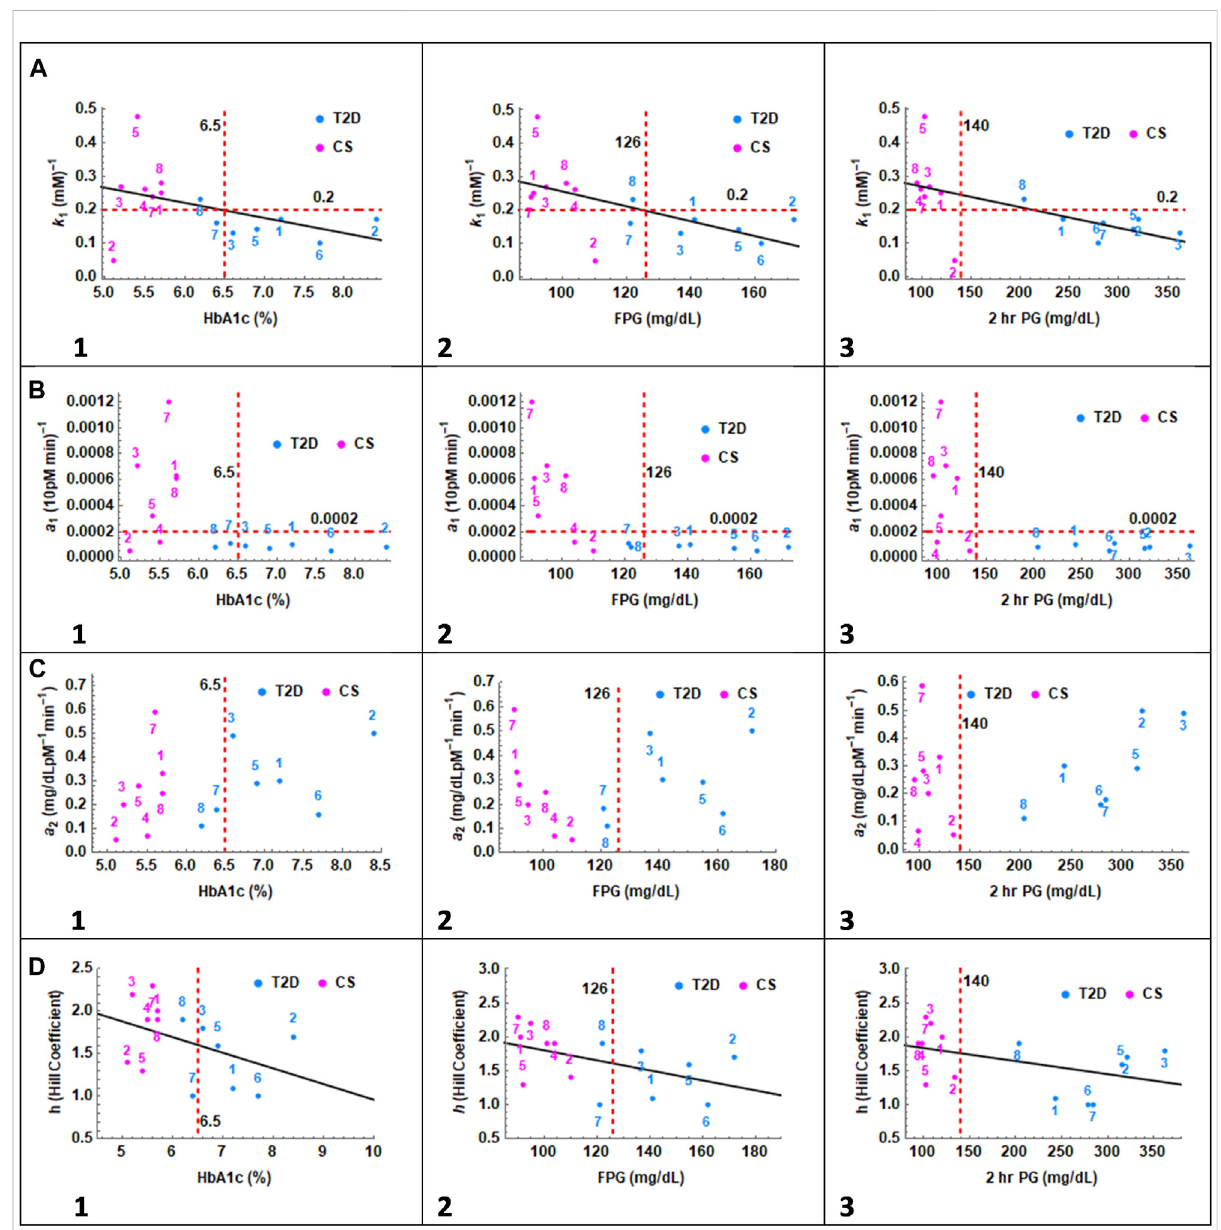
FIGURE 5 Intheseriesofpanels (A) through (G) ,theparametersrelatedtoglucagon suppressionk 1 ,insulinactiona 1 ,glucagon actiona 2 ,Hillcoef fi cienth, infused glucose, insulin secretion γ 1 and glucagon secretion γ 2 are plotted as a function of HbA1c, FPG and 2 h PG values. In panel (A) 1, 2, and 3, CS and T2D subjects partition into distinct quadrants except for one CS subject. A linear relationship is observed between glucagon suppression and HbA1c, FPG, and 2 h PG. The cutoff value separating patients with T2D, and CS subjects is set at 0.2. In Panel (B) , the correlation with insulin sensitivity parameter a 1 is presented. CS subjects and patients with T2D again partition into two distinct quadrants except for CS 2 and 4. The cutoff valueseparatingpatientswithT2D,andCSsubjectsis0.0002.Inpanel (C) nocleardistinctionbetweenpatientswithT2DandCSsubjectsisobserved withrespecttoglucagon actionparameter a 2 . InPanel (D) ,theHillcoef fi cient,h,istrendinghigher inCSsubjectstowardh (cid:2) twoandinpatients with T2D towards h (cid:2) 1. In Panel (E) , infused glucose, an indicator of the incretin effect, shows a linear trend with respect to HbA1C, FPG and 2 h PG, particularly in patients with T2D. In panel (F) , no difference in insulin secretion parameter, γ 1 , between CS and T2D is observed. In panel (G) , patients with T2D show a weak linear trend towards higher HbA1c and FPG values with increasing glucagon secretion